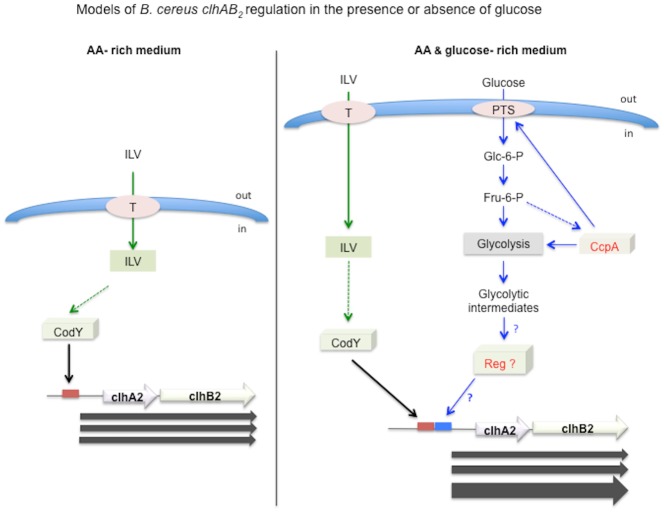
Two models for B. cereus clhAB2 regulation.Left: regulation of clhAB2 expression in an amino acid- rich medium. In a nutrient-rich medium (such as LB medium [13]), ILV uptake is sufficient to maintain the endogenous pool of ILV. The CodY global regulatory protein displays enhanced affinity for its DNA target when bound to ILV[27]. ILV-bound CodY binds to the CodY binding sequence upstream of clhAB2 and assists RNA polymerase with transcribing the clhAB2 operon (Figs 3 and 4). The expression level of clhAB2 is constant and moderate (i.e. basal level) during the late exponential and transition growth phases (Fig 1). Right: regulation of clhAB2 expression in an amino acid- glucose- rich medium. In LB medium with 0.35% glucose, ILV-CodY binds to the CodY motif and activates clhAB2 expression, but the expression profile is different (Fig 1). CcpA plays a positive role by indirectly regulating the transcription of clhAB2 (Fig 2) and this regulatory pathway remains to be characterized. The role of known or hypothetical effector molecules is depicted with a dashed arrow. In the left part, the ILV effector [27] is depicted with a green dashed arrow; in right part, the Fru-6-P [25] and unknown glycolytic intermediate effectors are depicted with blue dashed arrows. Moderate and constant clhAB2 expression is depicted by three identical gray arrows. High and gradual clhAB2 expression is depicted by three non-identical gray arrows. The intracellular ILV pool is depicted as a green box. The CodY motif sequence is depicted as a red box. The unknown DNA-binding motif is depicted as a blue box.?, unknown CcpA-dependent signaling pathway; ?, unknown transcriptional regulator. Fru-6-P, fructose-6-phosphate, Glc-6-P, glucose-6-phosphate. ILV, isoleucine, leucine, valine. CodY, CodY transcriptional regulator. CcpA, CcpA global carbon regulator; PTS, phosphotransferase system. T, unknown transporter of ILV.